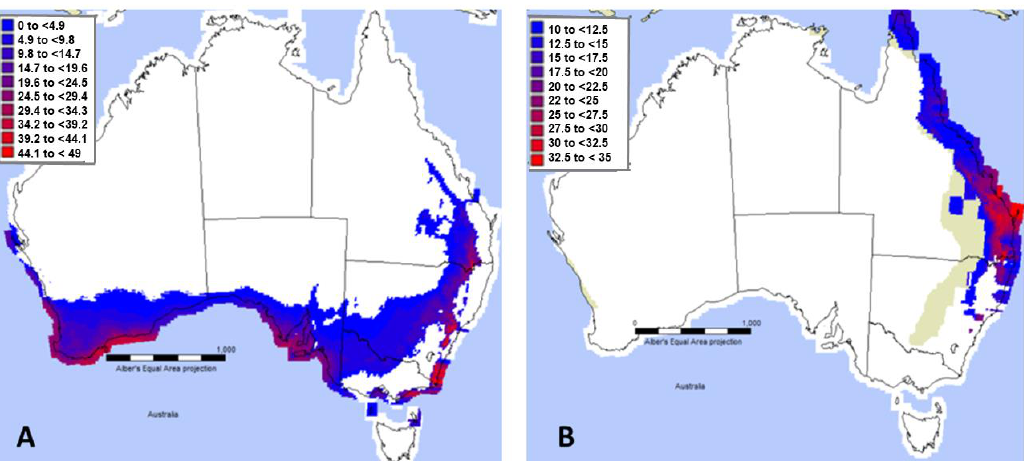
Figure 5. CLIMEX model output of Match Locations function using the Mediterranean climate default parameter file ( A ), and the same file modified using Leptocybe development data reported in [33] ( B ).